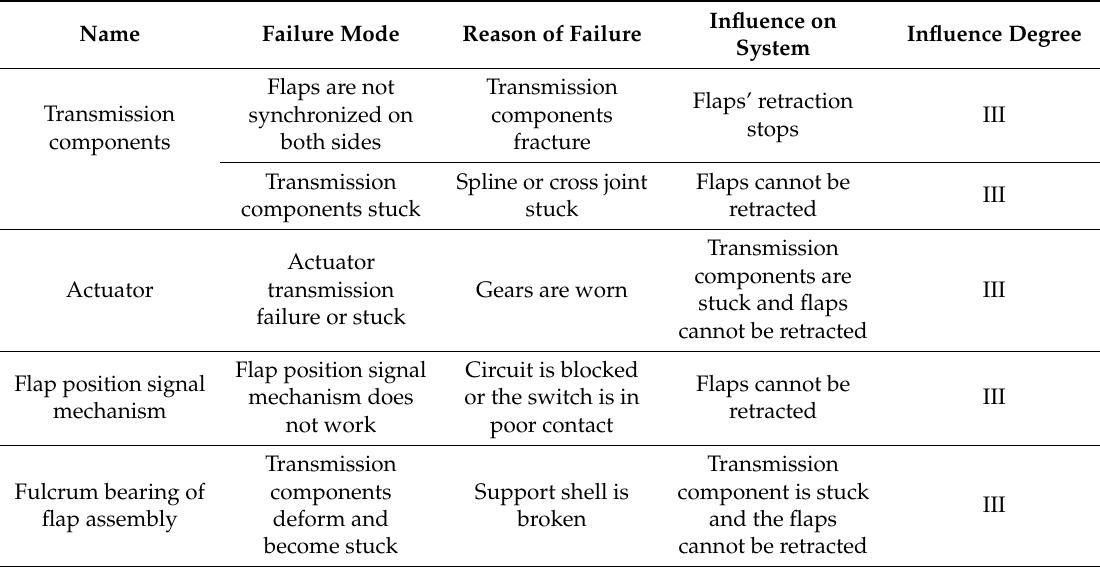
Table 2. FMEA of the flap system